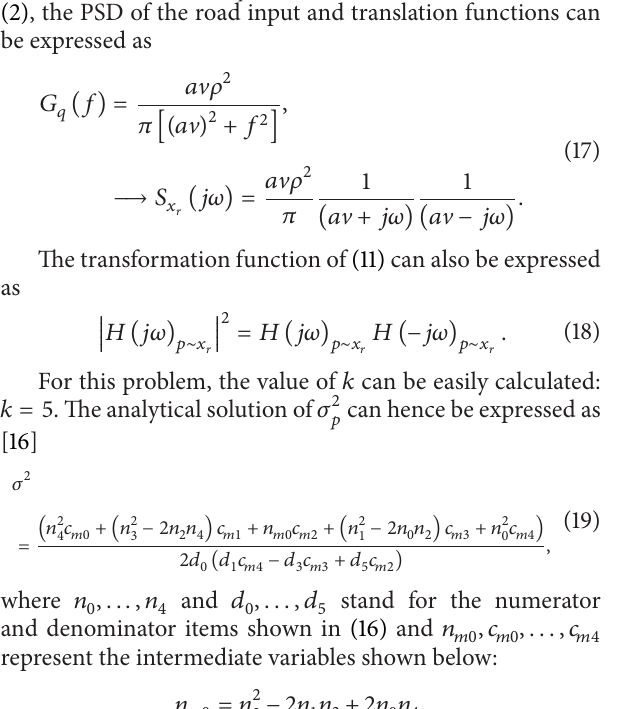
Figure 1: Ideal and equivalent models. (a) Ideal hybrid suspension system, (b) equivalent hybrid suspension system.